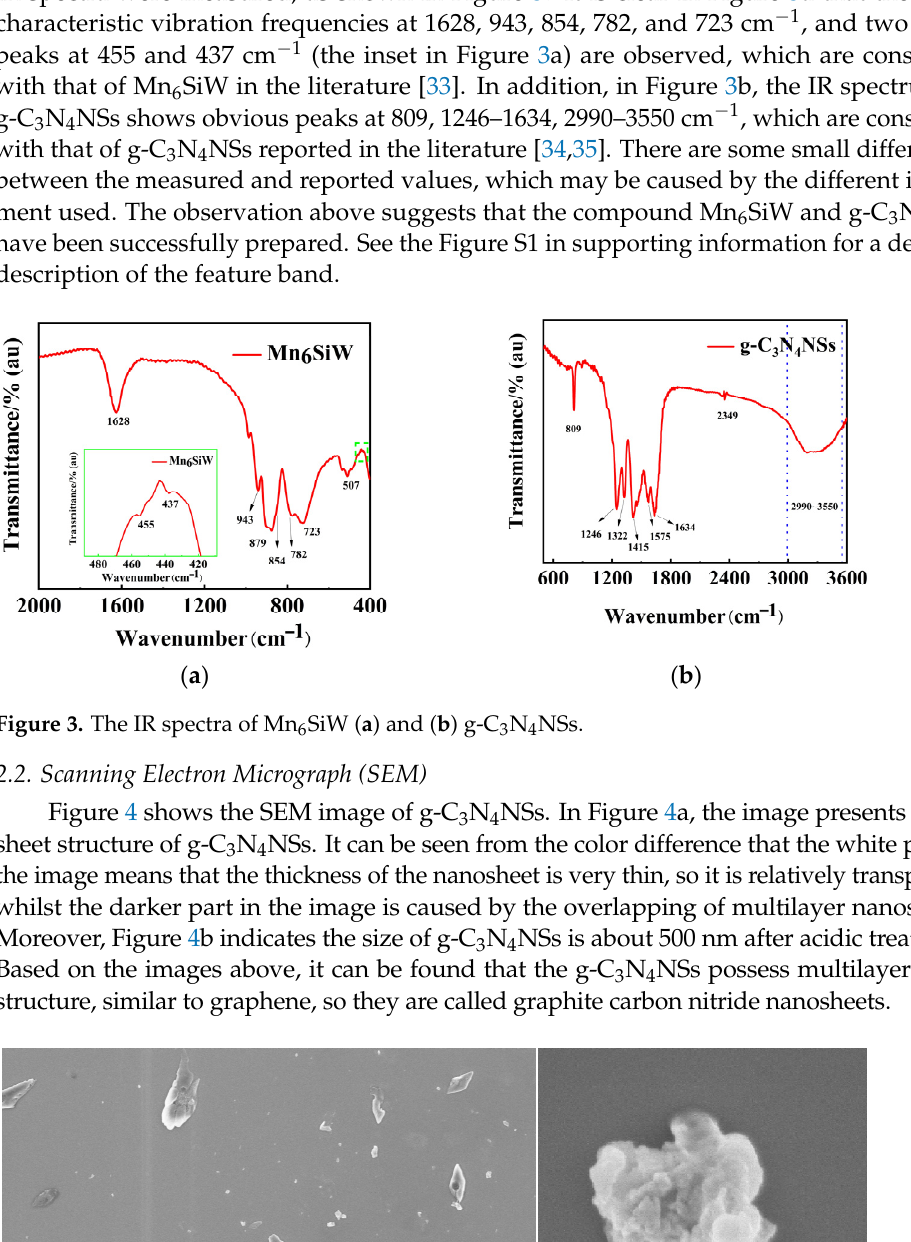
Figure 2. Structure of Mn 6 SiW; WO 6 polyhedra, purple; Mn, orange and brown; Si, green and O, red[33]. Reprinted with permission from ref. [33]. Copyright 2011 John Wiley and Sons.